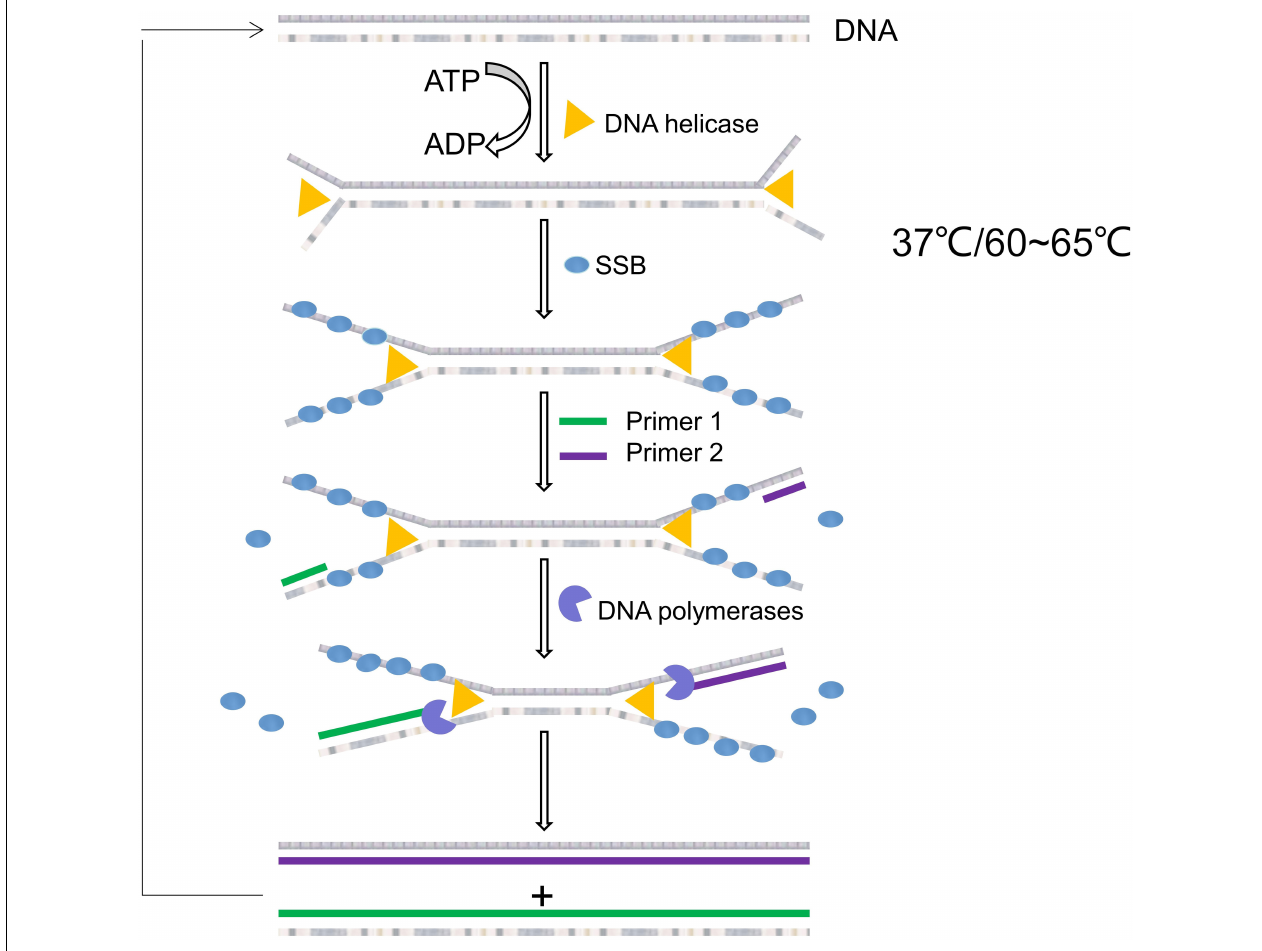
FIGURE 4 | Schematic diagram of helicase-dependent amplification.